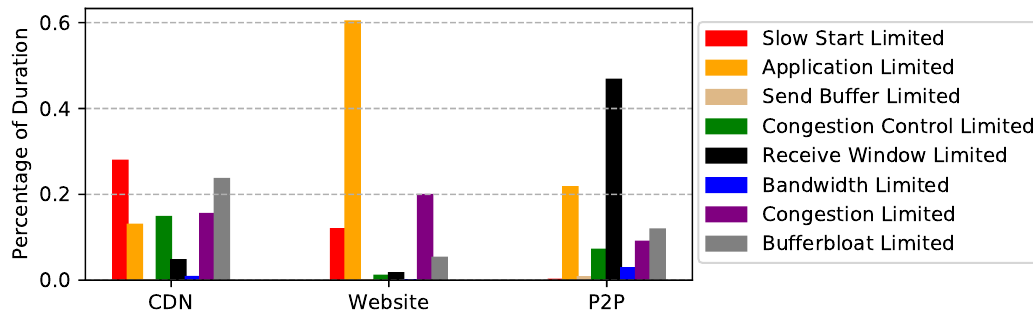
Figure 10. Percentage of duration for each limiting factor.